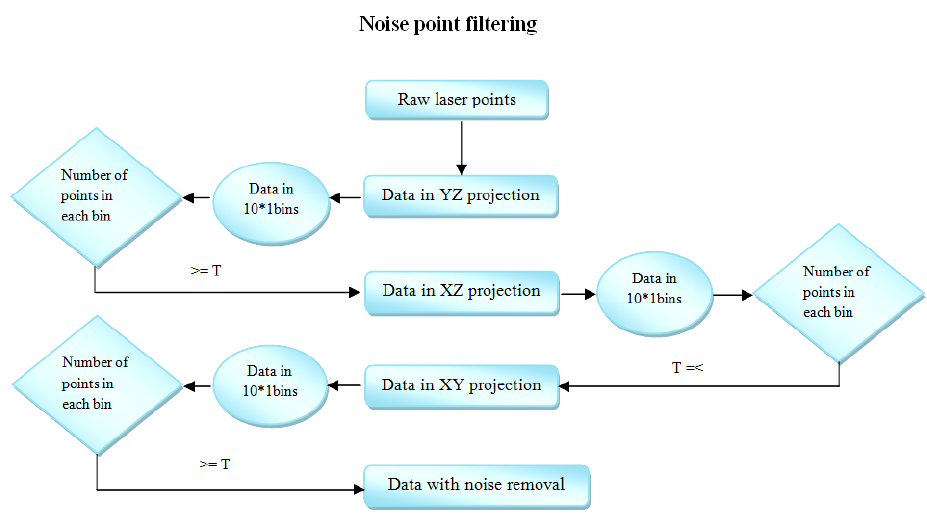
Figure 4. The procedure in noise point filtering.